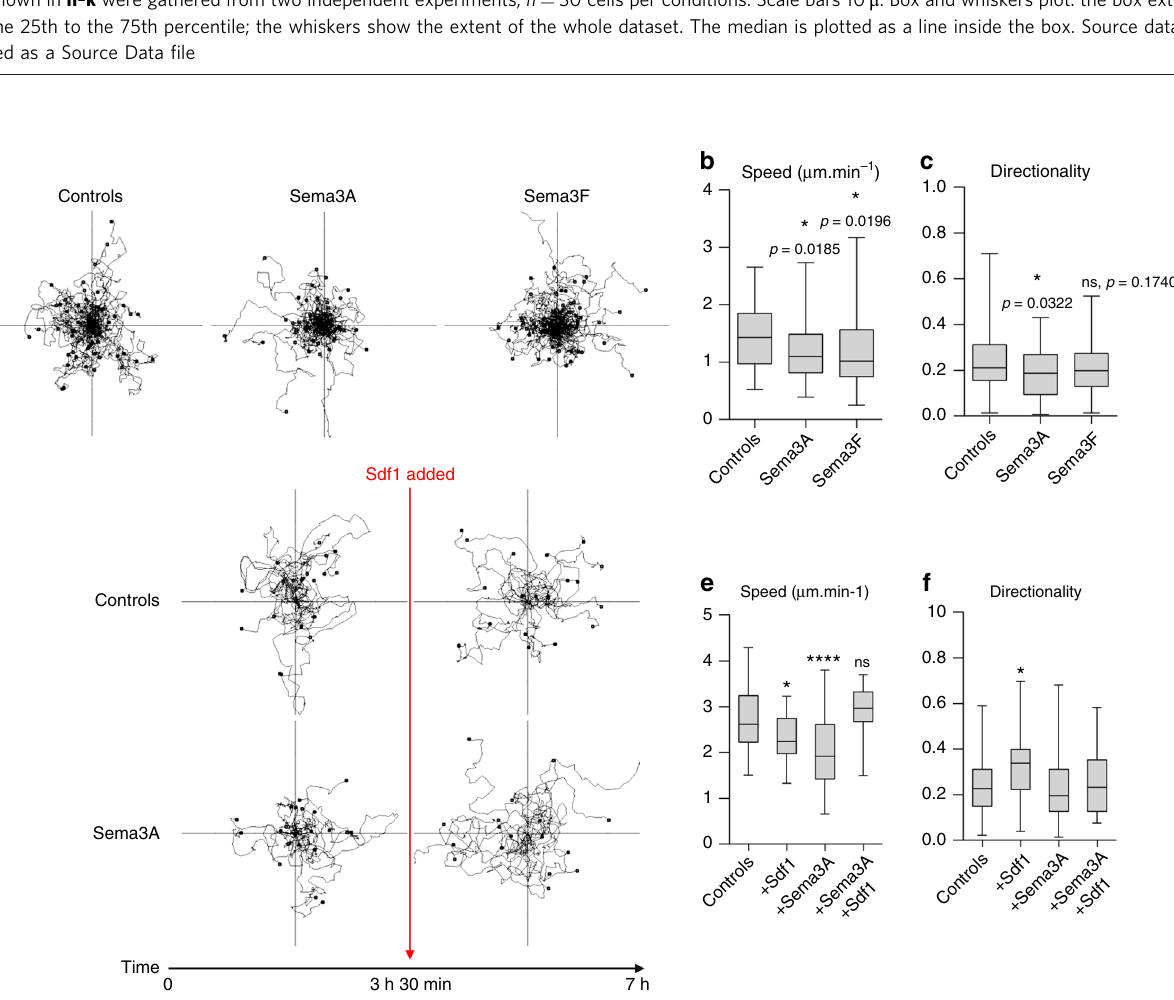
Fig. 4 Sdf1 and Sema3A have opposite effects on spreading, adhesions and protrusions. a DAPI (blue) and Phalloidin staining (green) on NC cells cultured in control conditions or exposed to Sdf1 and/or Sema3A. b Colour-coded time projection of time-lapse movies of cells transfected with life-Act-GFP (see Supplementary Movie 8). c – e Area occupied by the cells, normalised to control conditions ( c ), circularity ( d ) and aspect ratio ( e ), n = 105 cells ( n controls =